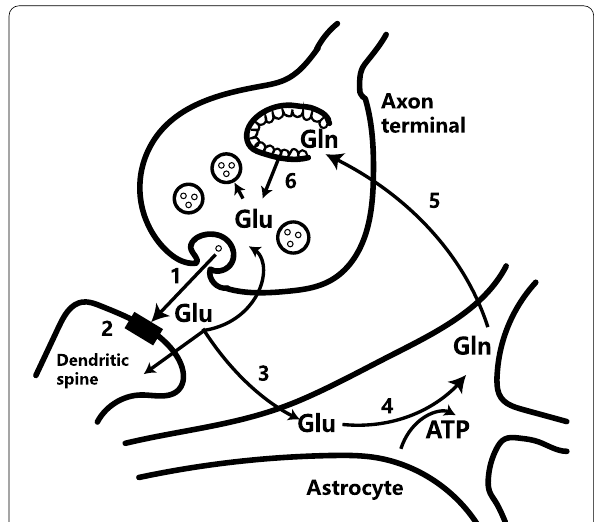
Fig. 1 Illustration of the glutamate–glutamine cycle. (1) When receiving a nerve impulse, glutamate is released from vesicles in the axon terminals into the synaptic cleft. (2) Glutamate binds to postsynaptic glutamate receptors. (3) Part of the glutamate diffuses rapidly from synapses and is taken up into astrocytes and neurons by excitatory amino acid transporters (EAATs). (4) Glutamate in astrocytes is converted to glutamine via the enzyme glutamine synthetase (GS). (5) Glutamine is then shuttled from astrocytes to neurons via glutamine transporters. (6) After entering neurons, glutamine is converted to glutamate by glutaminase (GLS), and glutamate is concentrated in synaptic vesicles via vesicular glutamate